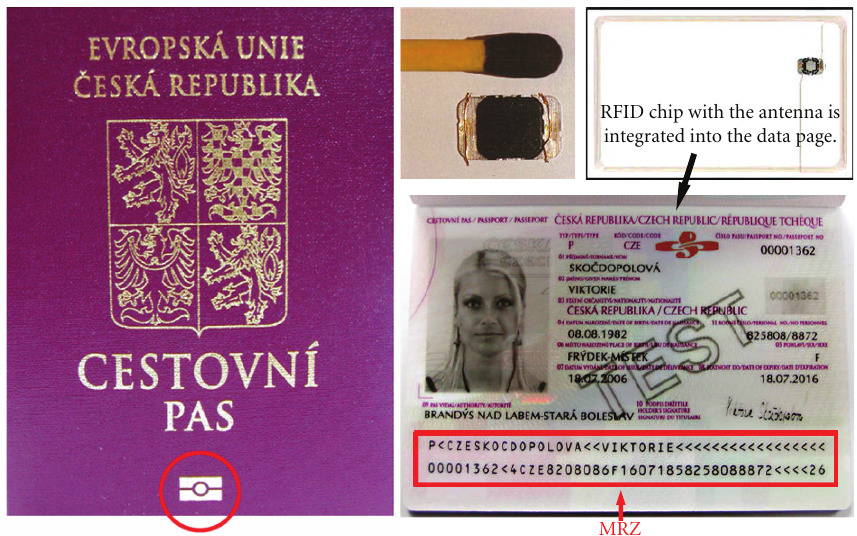
Figure 1: On the left: a Czech biometric passport specimen with circled international logo of electronic passports; top right: RFID chip without and with antenna; bottom right: data page with labelled MRZ (source: